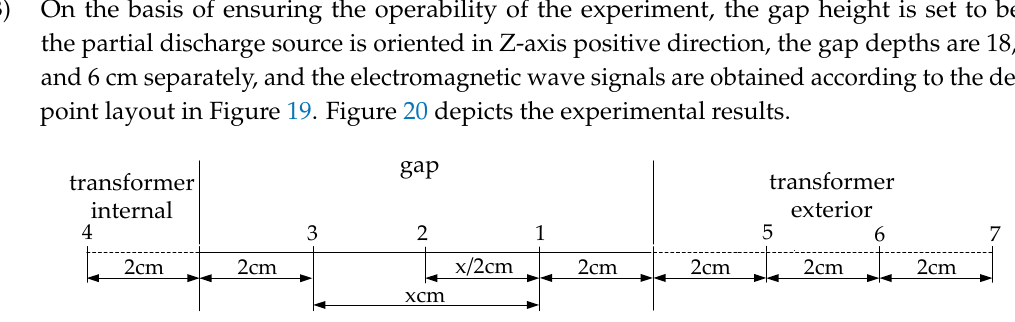
Figure 19. Layout of the detection point of experiment (transformer gap is (x + 4) cm high and 5 cm deep).